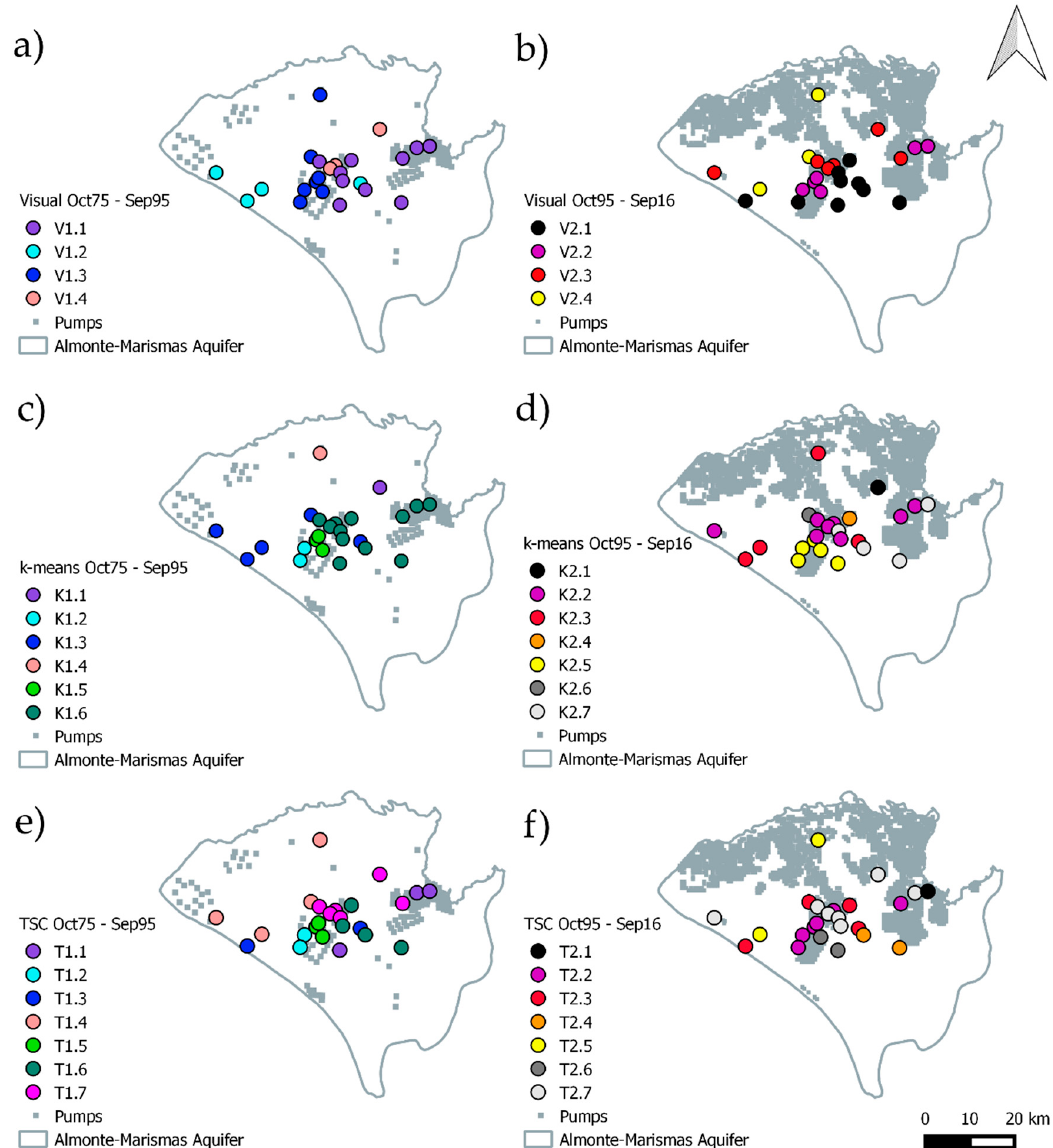
Figure 3. Spatial distribution of piezometer groups for the three clustering methods applied. An approximate distribution of the pumping wells [25,43] is shown in grey. ( a ) Visual clustering for first sub-period (October 1975 to September 1995); ( b ) Visual clustering for second sub-period (October 1995 to September 2016); ( c ) k-means clustering for first sub-period; ( d ) k-means clustering for second sub-period; ( e ) Time series clustering (TSC) for first sub-period; ( f ) TSC for second sub-period.